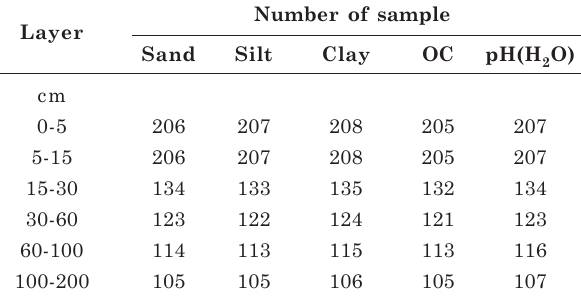
Table 1 Number of samples used per soil property and the depth of the layer after removal of